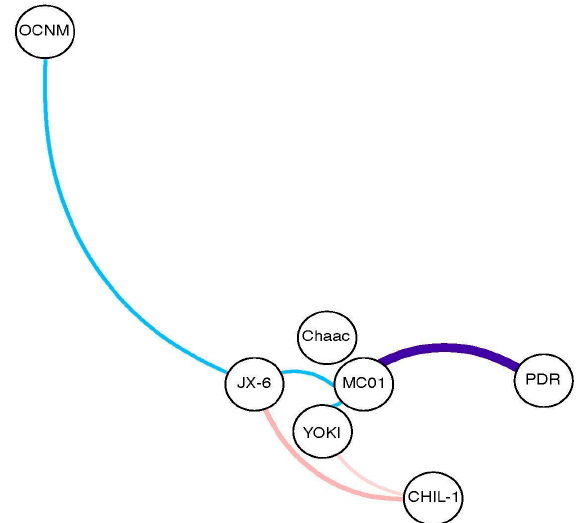
Figure 10. Network plot for high resolution records covering the last 2000 years. See Figure 7 for further details. Pairwise gXCF values are shown in Table 2. Records shown are from Chilbrillo Cave (CHIL-1), Juxtlahuaca Cave (JX-6), Machal Chasm (MC01), Oregon Caves National Monument (OCNM), Perdida Cave (PDR), Tzabnah Cave (Chaac), and Yok Balum Cave (YOKI).